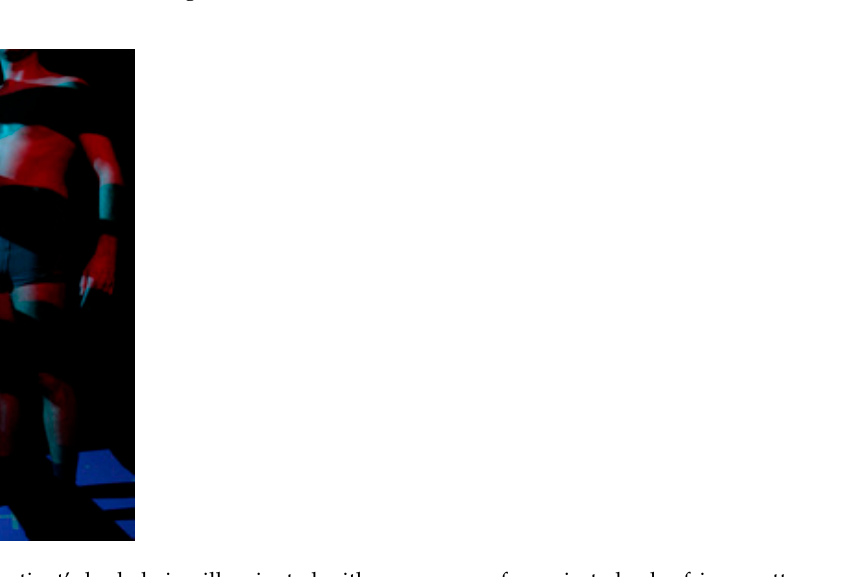
Figure 2. A patient’s body being illuminated with a sequence of a projected color fringe patterns.